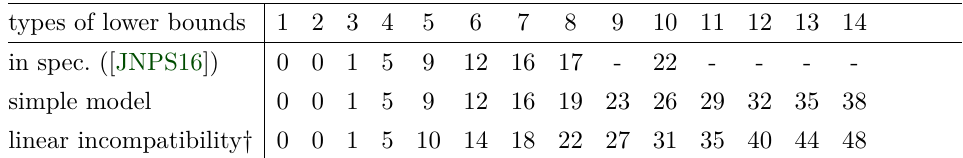
Table 1: Old and new lower bounds on the number of active S-boxes for Deoxys-BC .